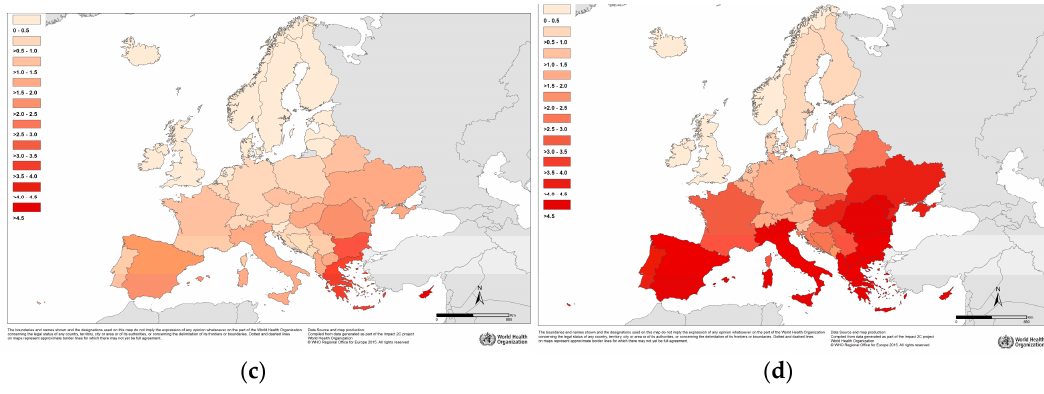
Figure 1. Attributable fraction (AF) of heat-related deaths during summer by country in European sub-region in 2050: ( a ) Using MOHC model in RCP 4.5; ( b ) Using MOHC model in RCP 8.5, and in 2085: ( c ) Using MOHC model in RCP 4.5; ( d ) Using MOHC model in RCP 8.5.